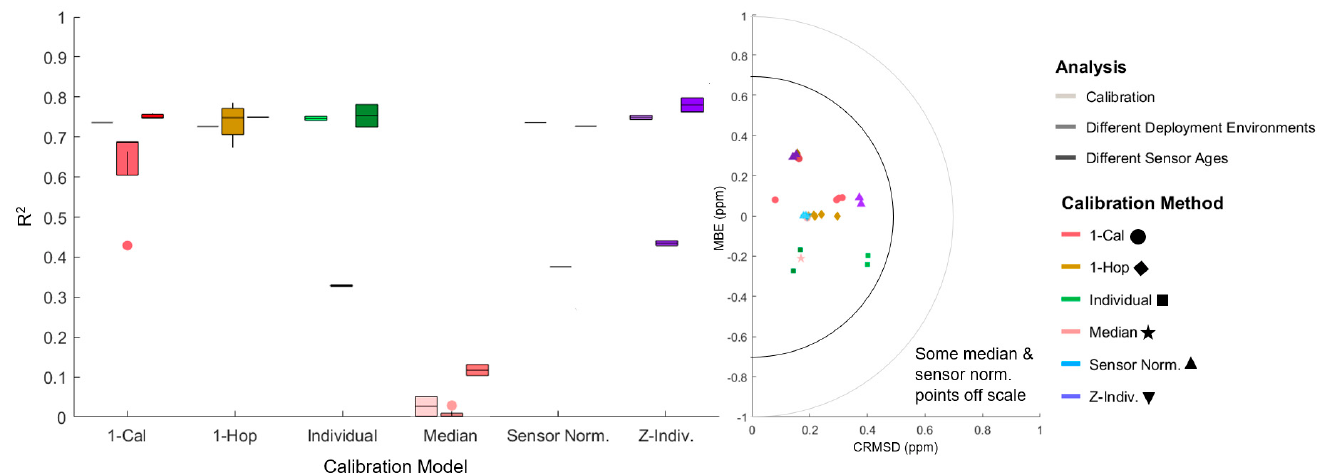
Figure 6. Methane R 2 boxplot ( left ) and MBE vs. CRMSD target plot ( right ) for calibration models applied to sensors of different ages (light) and deployed in different environments (dark shading). Within each boxplot column, calibration data is leftmost, different deployment environment data is center, and different sensor age data is rightmost.